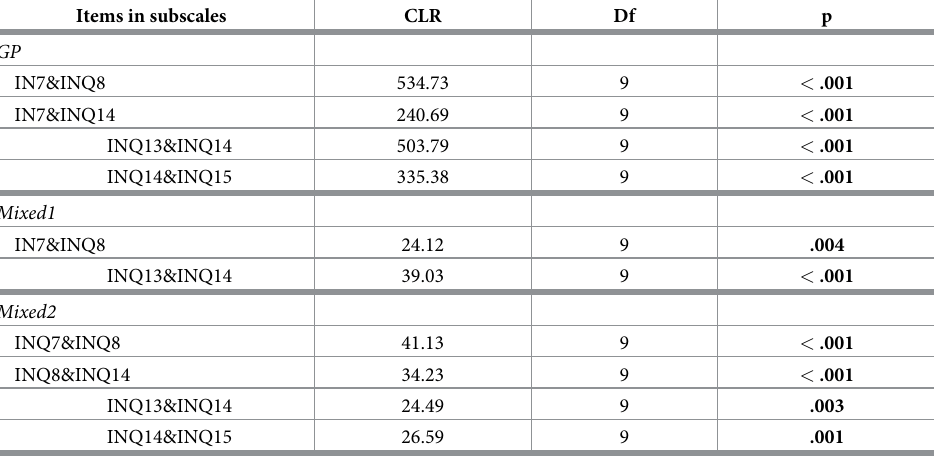
Table 7. Conditional likelihood ratio tests of local dependence under the respective GLLRMs for the TB-subscale in the different samples. Items in subscales